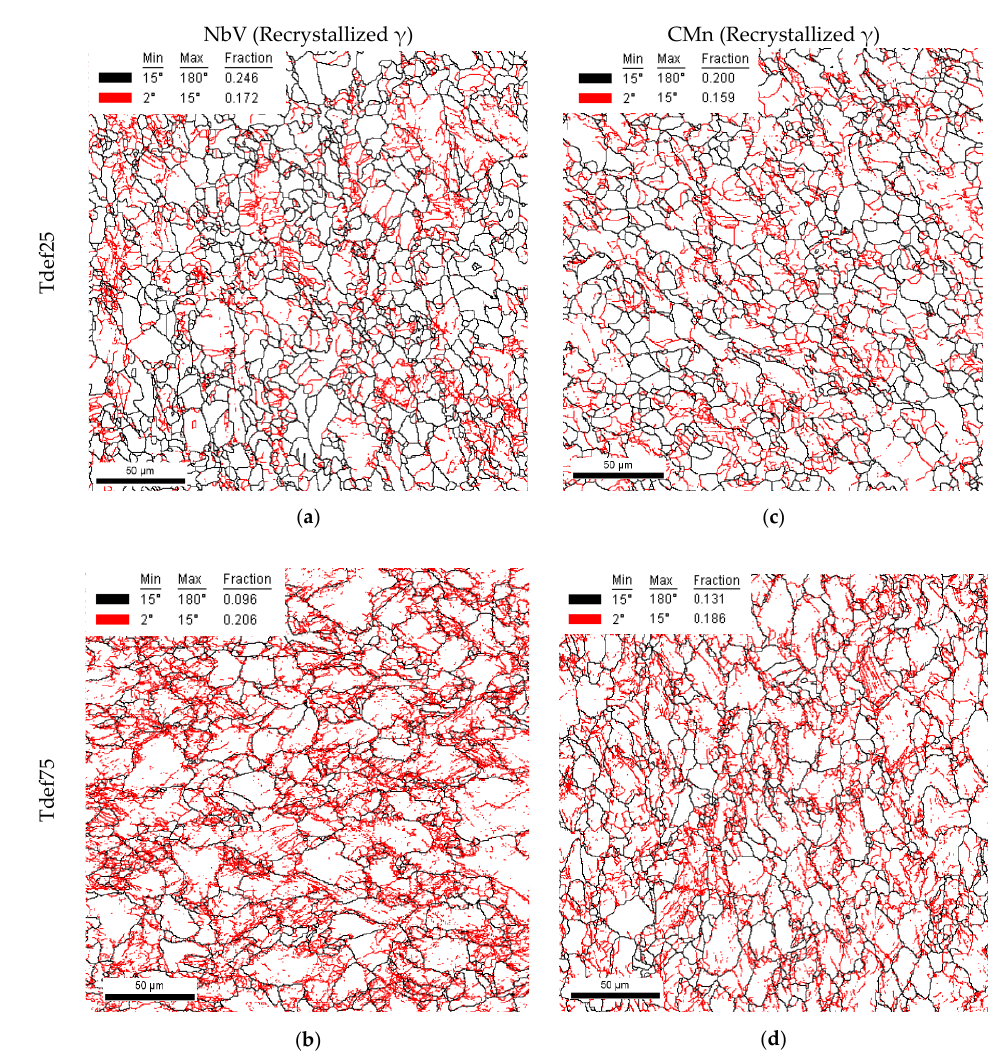
Figure 6. Grain boundary maps (low and high angle boundaries, in red and black color, respectively) corresponding to ( a , b ) NbV recrystallized austenite and ( c , d ) CMn. Di ff erent ferrite levels prior to deformation have been included: ( a , c ) Tdef25 and ( b , d )